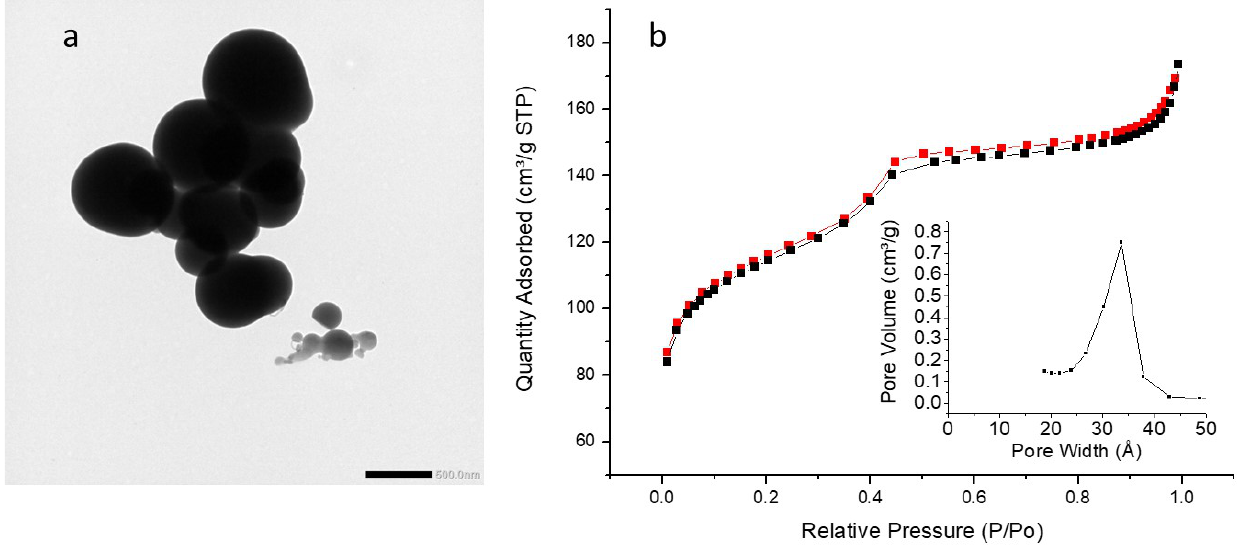
Figure 14. ( a ) TEM image of EtbiPyPMO 10 scale bar 500 nm. ( b ) Nitrogen adsorption–desorption at 77 K. Insert BJH desorption (dV/dlog(w)) Pore Volume.